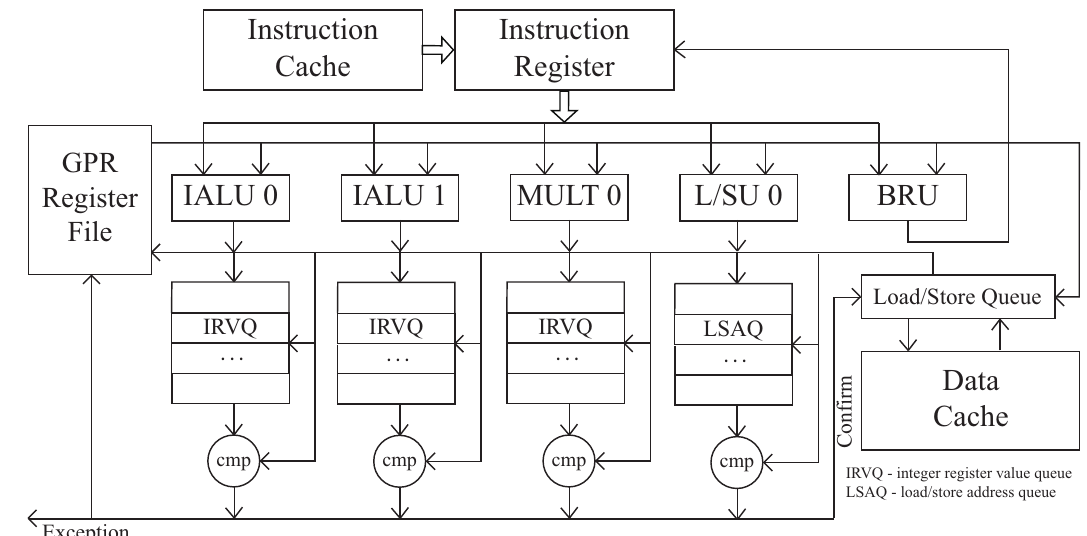
Figure 1. Our VLIW architecture needs additional queues to store temporal results from original and redundant instructions (e.g., IRVQ and LSAQ), and it also needs comparator (cmp) to detect soft